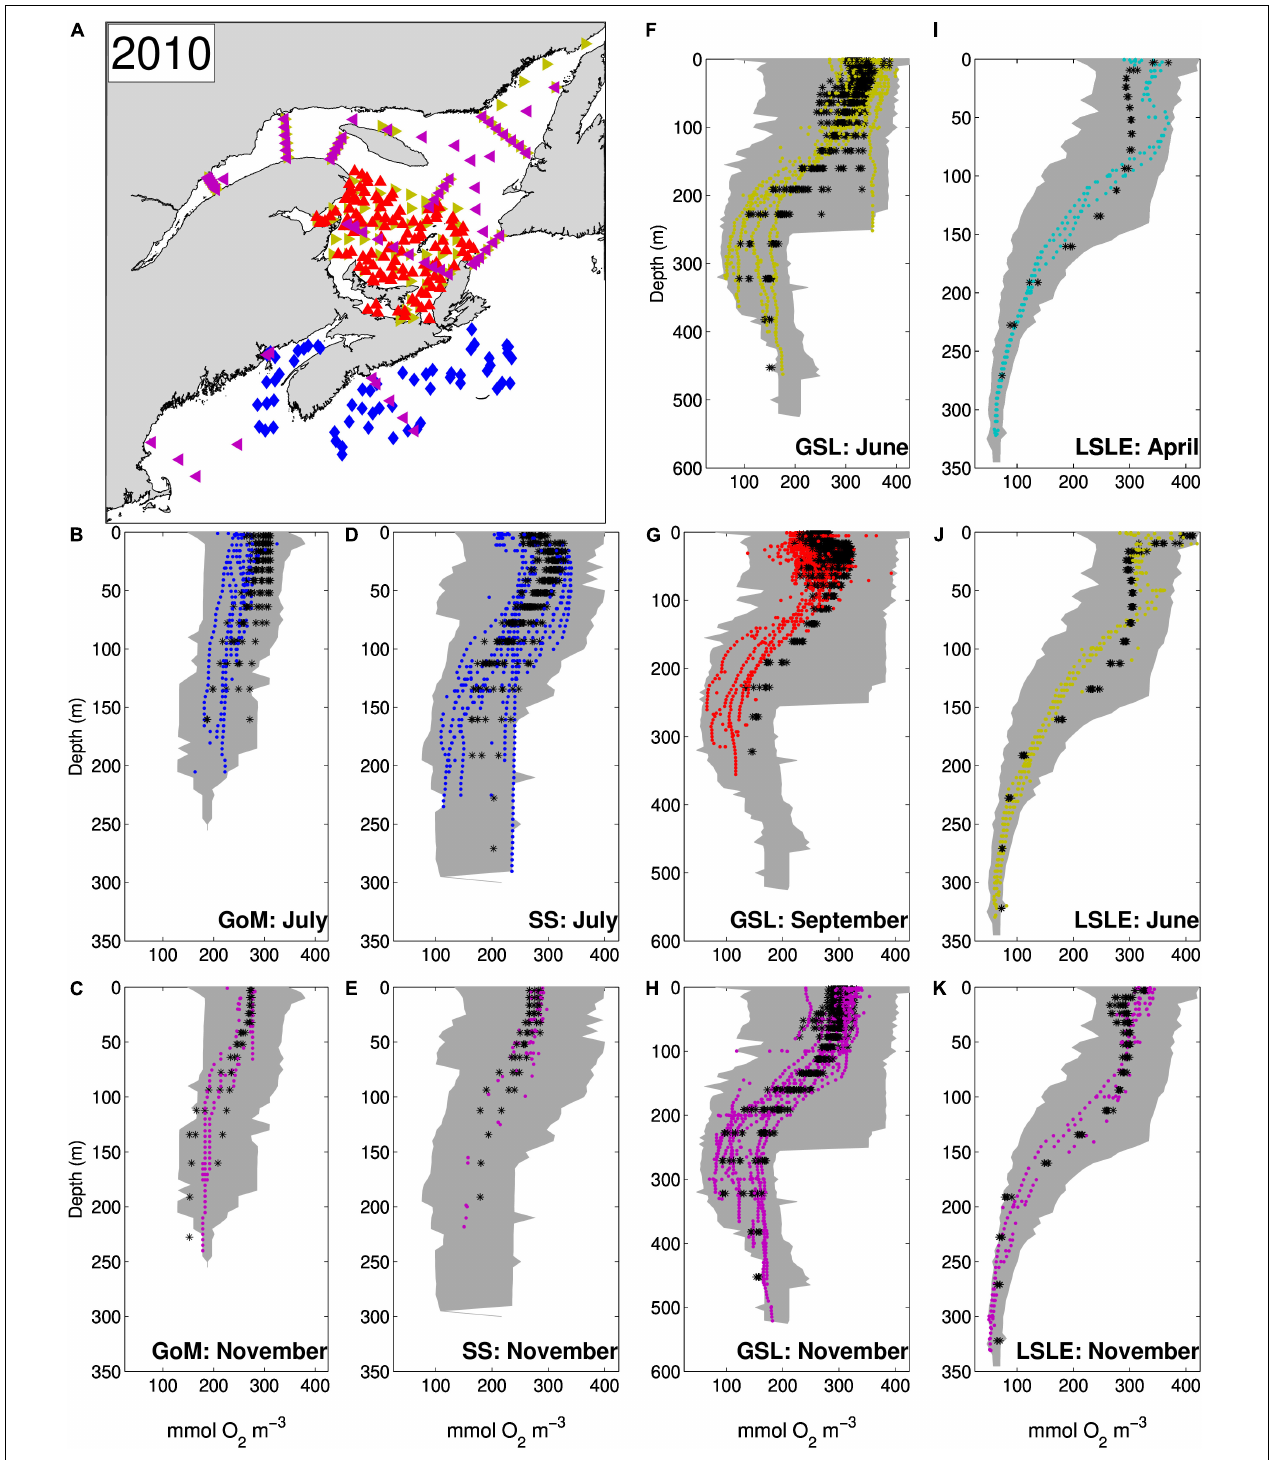
FIGURE 10 | (A) Map showing the location of DO sampling in 2010 [the symbol colors indicate the month during which sampling occured, April (cyan), June (yellow), July (blue), September (red) and November (magenta)]. The observed (colored symbols) and simulated (black stars) DO profiles are compared for different regions shown in Figure 1 , GoM (panels B,C ), SS (panels D,E ), GSL (panels F–H ), and LSLE (panels I–K ). The shaded area represents the range of observed values in the same regions over years 2008 to